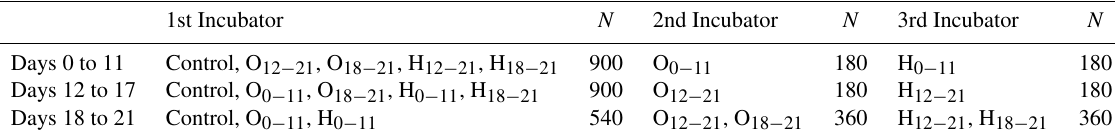
Table 1. The experimental